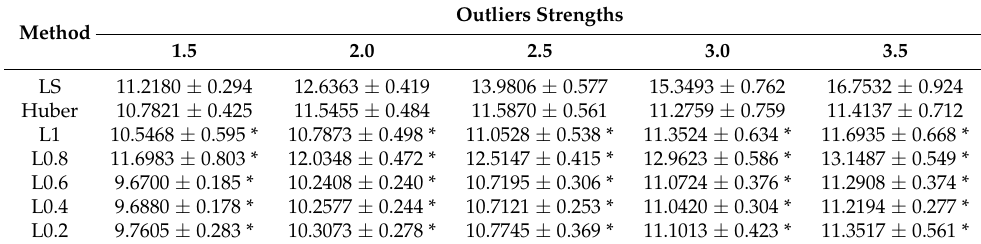
Table 8. Fitting errors of the TISO system with different outlier